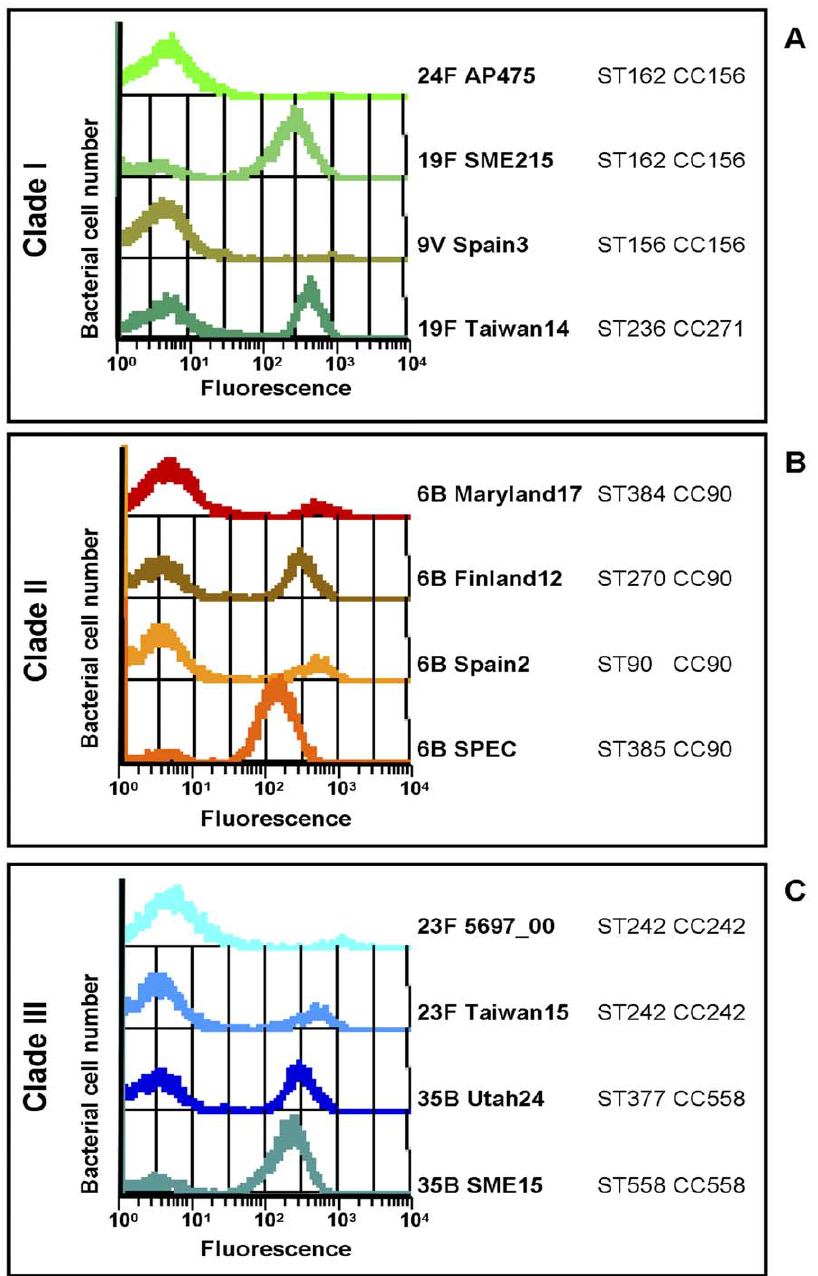
Figure 2. Pilus expression ratio is not correlated with serotype, genotype or clade type. Bacteria containing either PI-1 clade I (A), clade II (B) or clade III (C), were labeled with clade specific anti-RrgB antibodies (1:400 dilution) and FITC anti-mouse IgG secondary antibodies (1:100 dilution). Pilus-1 expression was then analyzed by flow cytometry (FACS-Calibur).